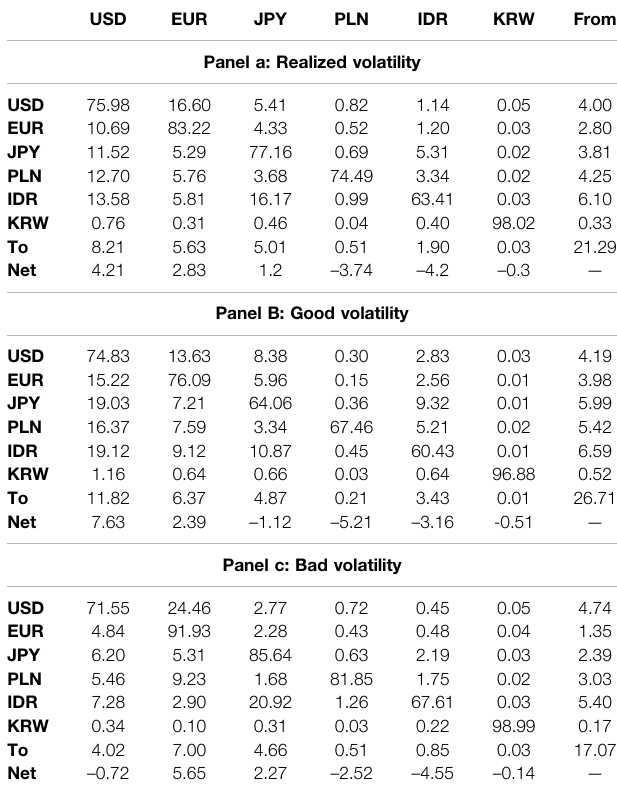
TABLE 2 | Static spillover in realized, good, and bad